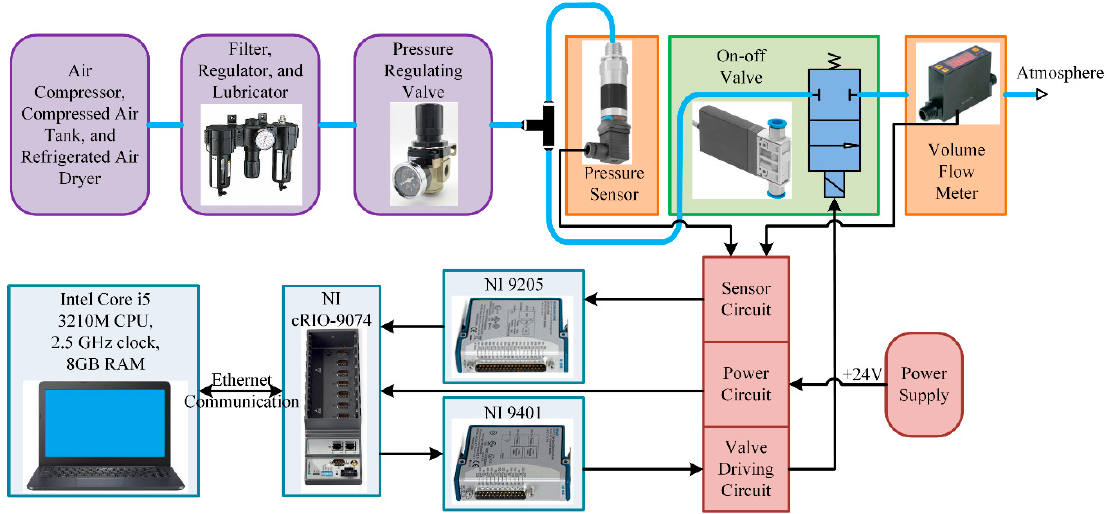
Figure 2. Experimental setup of measuring the volume flow. Central Processing Unit (CPU), RAM (Random Access Memory), National Instruments (NI), and CompactRIO (cRIO).